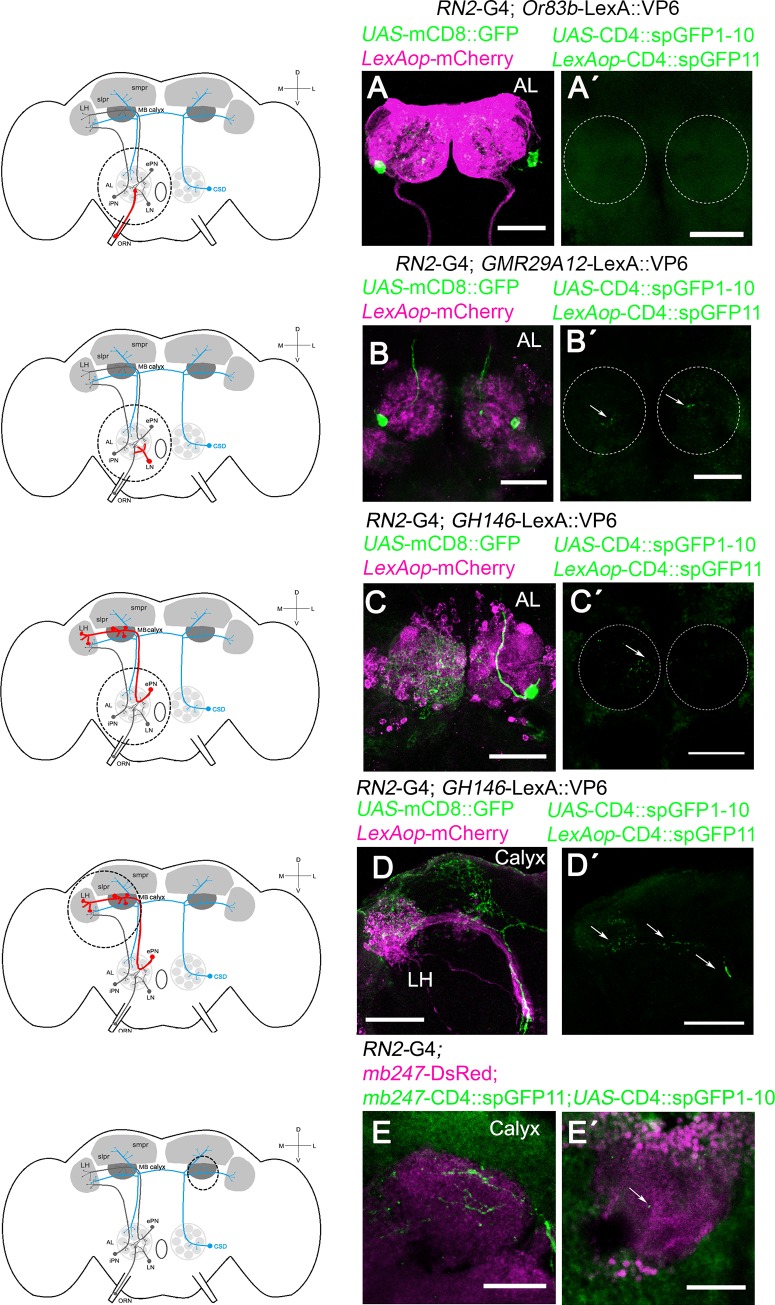
The connections between CSD neurons and LNs, PNs, or Kenyon cells.A schema is provided indicating the region of interest with a circle, the CSD neuron in blue and neurons of interest in red. The dots indicate that a second set of neurons exist in opposite brain hemisphere. A-D, the CSD neurons are labeled using UAS-mCD8::GFP under the control of RN2-GAL4 in green. The expression pattern of the, A, Or83b-LexA::VP16 driver targeting the ORNs, B, GMR29A12-LexA targeting the LNs and, C-D, the GH146-LexA targeting the PNs with projections in the AL, LH and MBs are visualized using the LexAop-myr::mCherry transgene (in magenta). In A´-E´,
RN2-GAL4 drives the expression of the UAS-CD4::spGFP1-10 transgene and, in A´-D´, LexA drives the expression of the LexAop-CD4::spGFP11 transgenes. In E and E´, the mb247-DsRed; mb247-CD4::spGFP11 transgenes label the MBs in magenta, and spGFP11 is expressed under the control of the MB-specific promotor mb247. In E GFP expression targeted by the RN2- driver and mb247-DsRed are shown. In B´- E´, the reconstituted GFP is seen as green dots. Dashed circle indicates the approximate position of ALs, and the arrow in B´-E´ indicates the reconstituted GFP signal. Scale bar is 50 μm in A—D´ and 25 μm in E and E´.